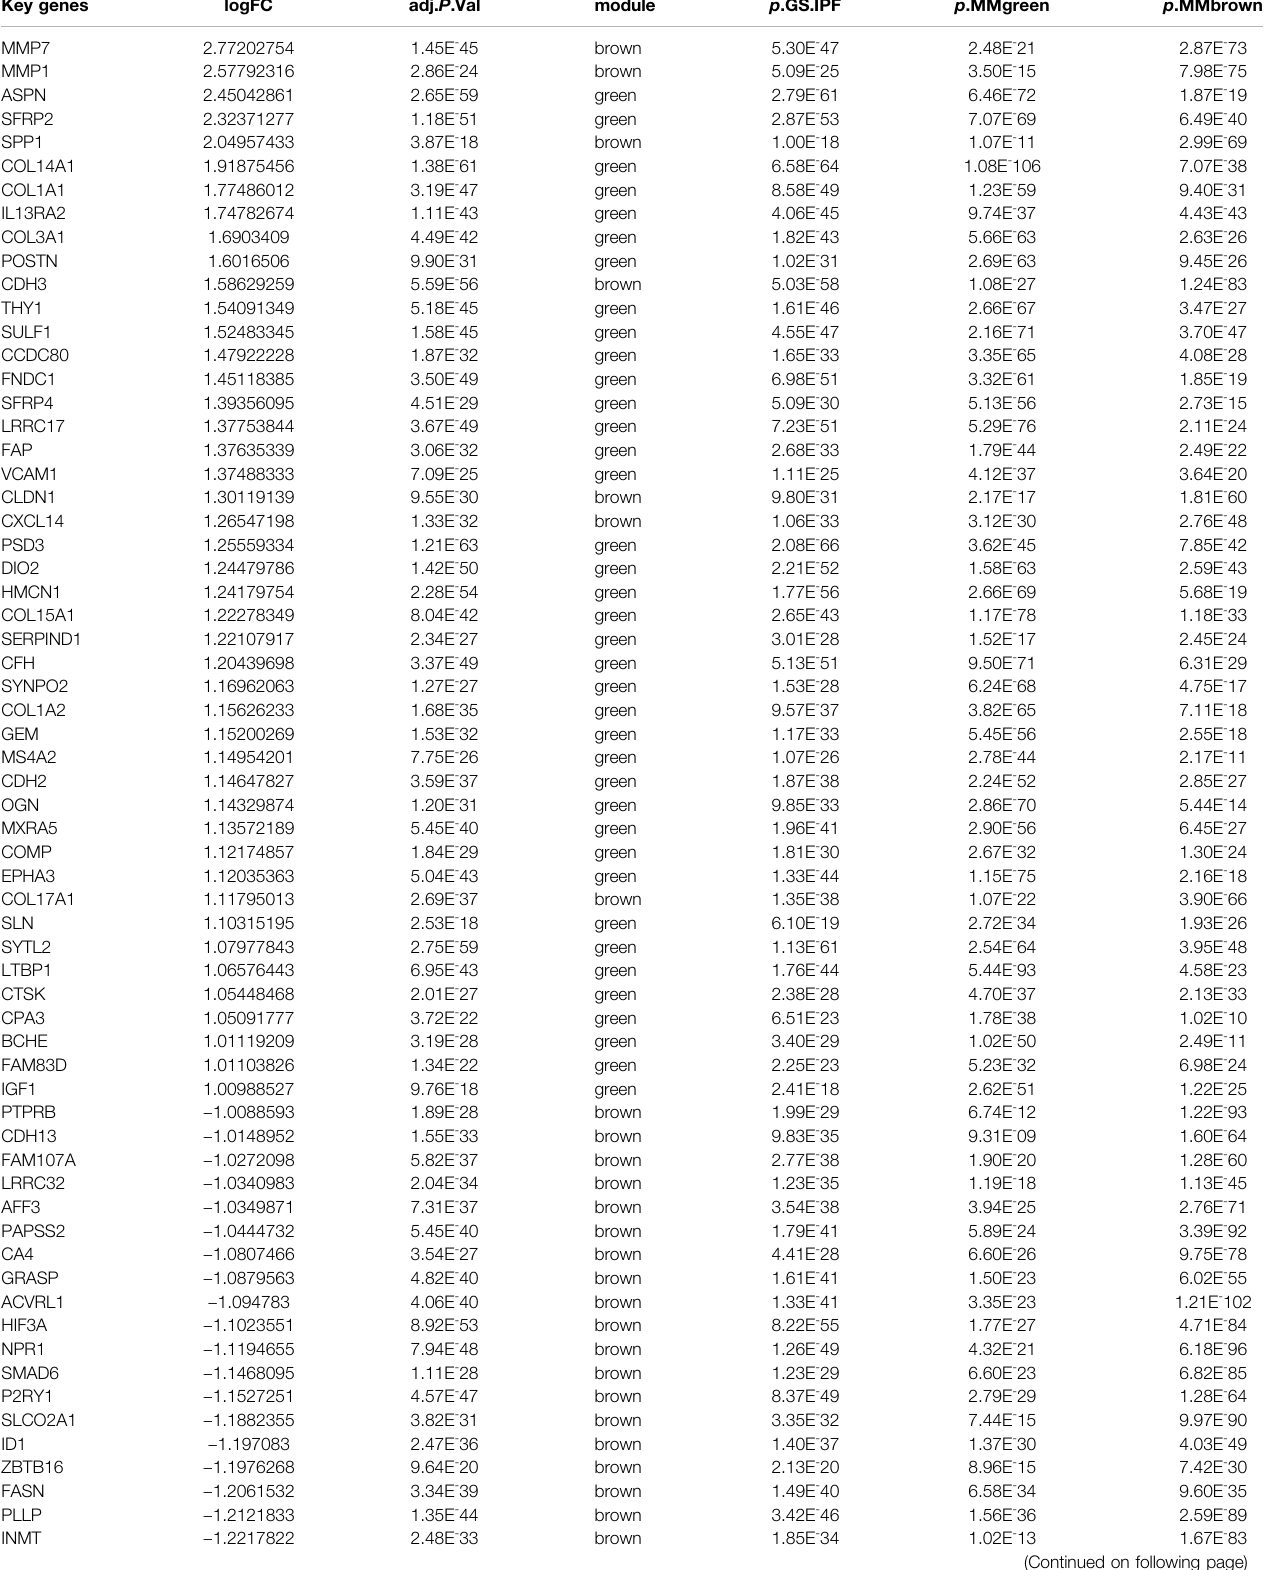
TABLE 4 | Key genes in the training group. Key